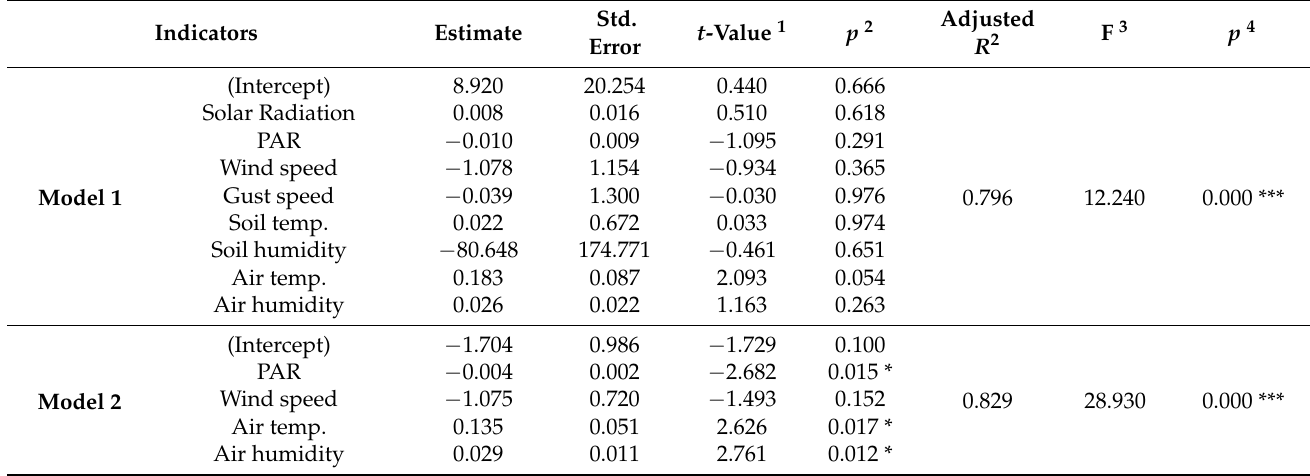
Table 3. Multiple regression results of Model 1 and Model 2.